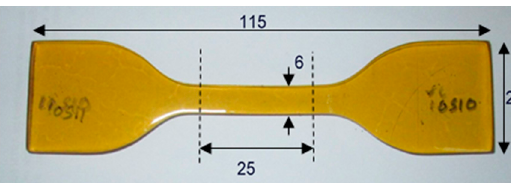
Figure 1. Sketch of the tensile test specimen with dimensions (Note: Not to scale, all dimensions shown are in mm).